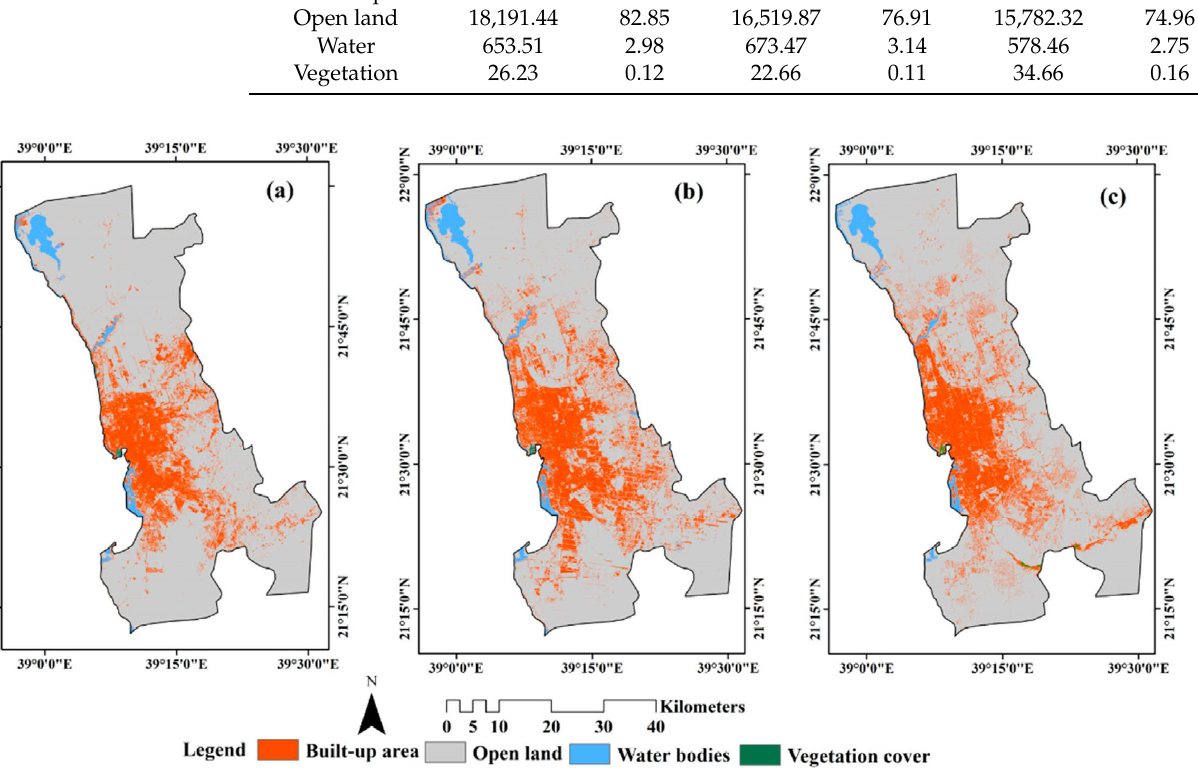
Figure 2. Land use and land cover (LULC) in Jeddah: ( a ) 2000, ( b ) 2010, and ( c ) 2021. Table 2. LULC in Jeddah megacity for the indicated years.